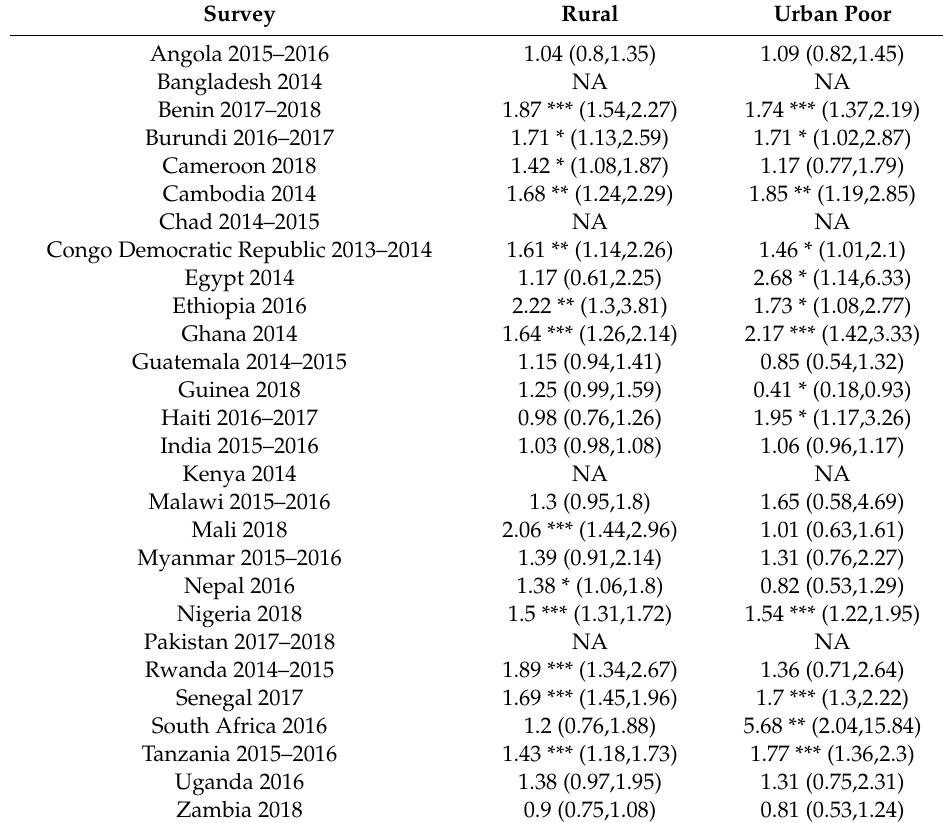
Table A2. Adjusted odds ratios of moderate or severe anemia for children living in urban poor and rural clusters compared to children living in urban non-poor